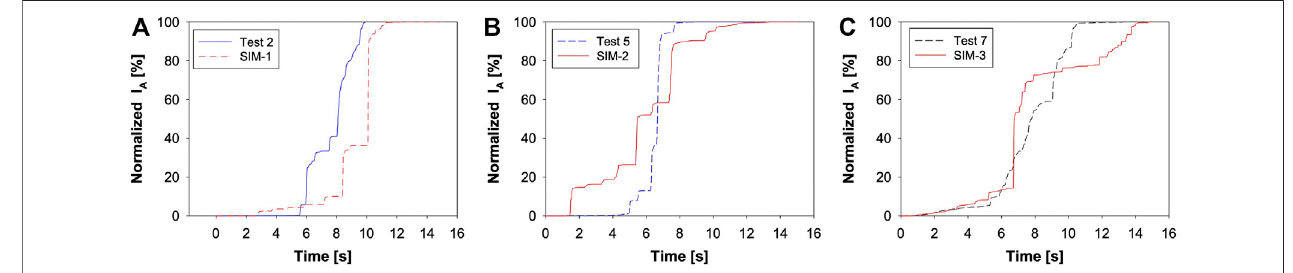
FIGURE 11 | Husid plots of seismic signals form Pt. c and Acc. 3: (A) single large rockfall, (B) single small rockfall, and (C) rock mixture fall.